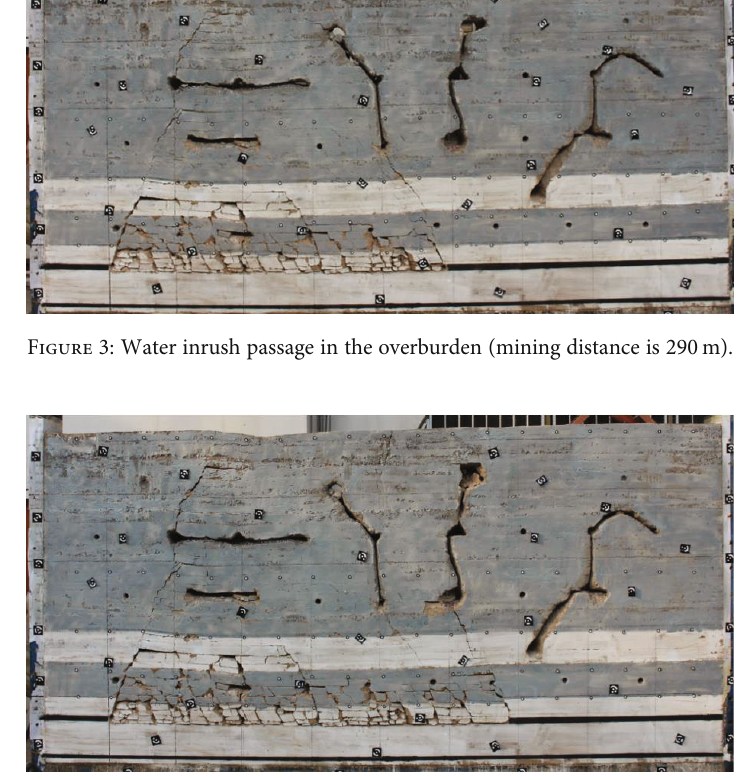
Figure 4: Water inrush passage in the overburden (mining distance is 350